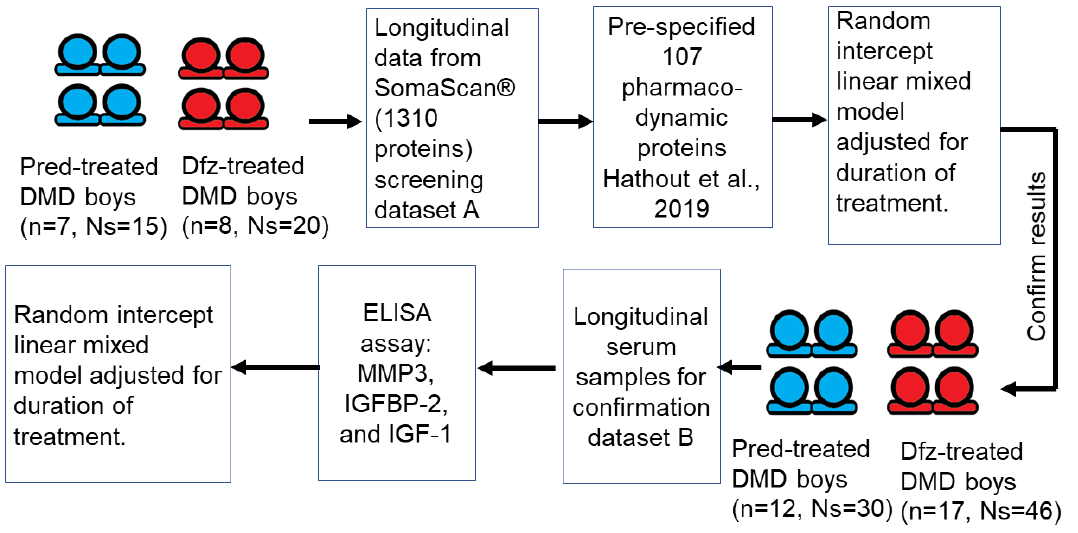
Figure 2. Schematic describing the workflow for the biomarker analyses. Proteins identified as differentially affected by prednisone vs. deflazacort were identified from the SomaScan ® based screening dataset. This was followed by confirmation analysis using ELISA assays of three selected biomarkers on a larger set of subjects (confirmation dataset). n: number of subjects, Ns: number of serum samples used in this study.